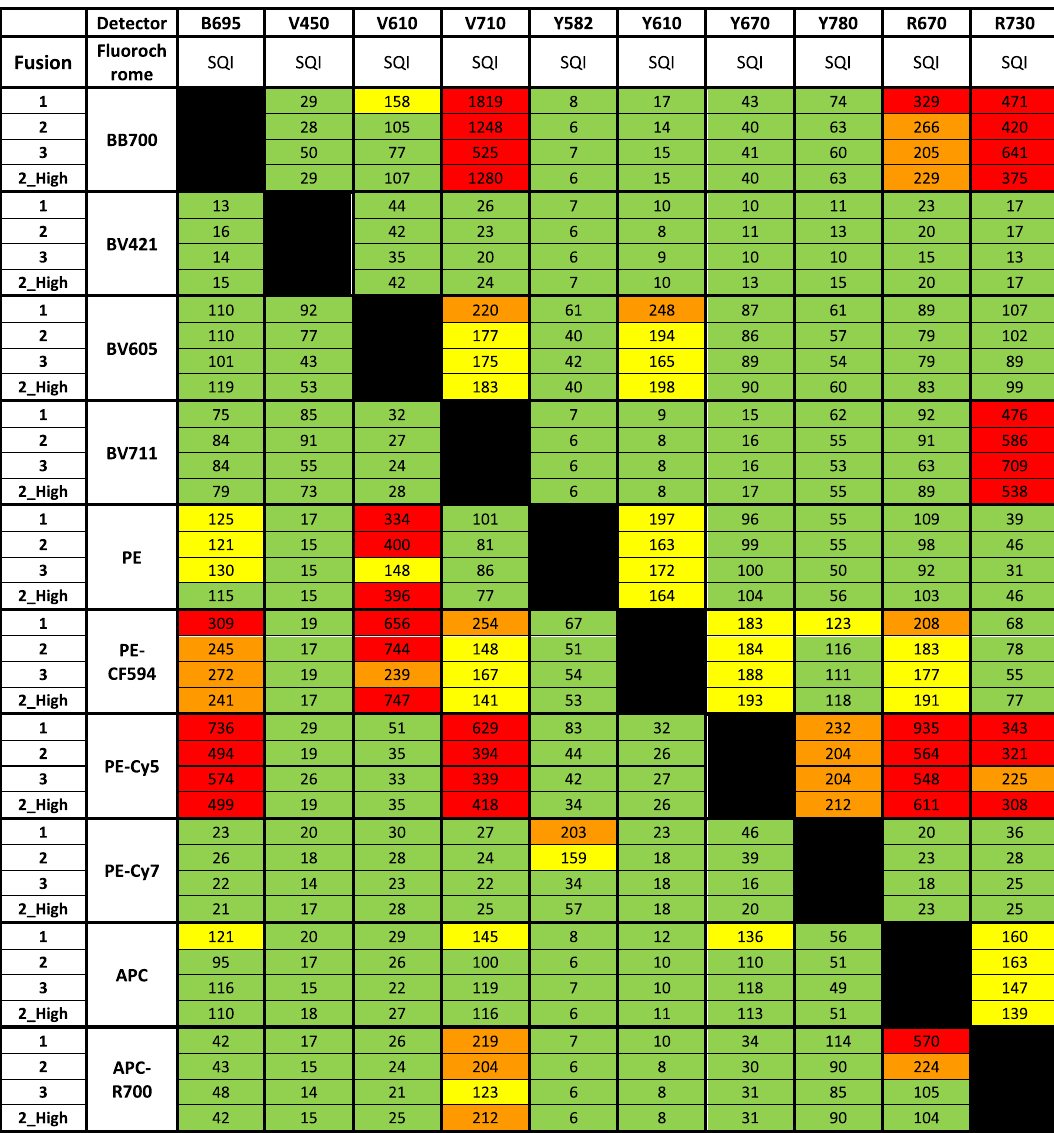
Table 2. Comparison of all four Fusion setup: the SQI values for 10 fluorochromes run on three different Fusions are shown. For Fusion 2, “2_High” denotes higher laser power as for the other two instruments. The SQI values are categorized as follows: 1–120 (Green); 121–199 (Yellow); 200–299 (Orange); and 300 +